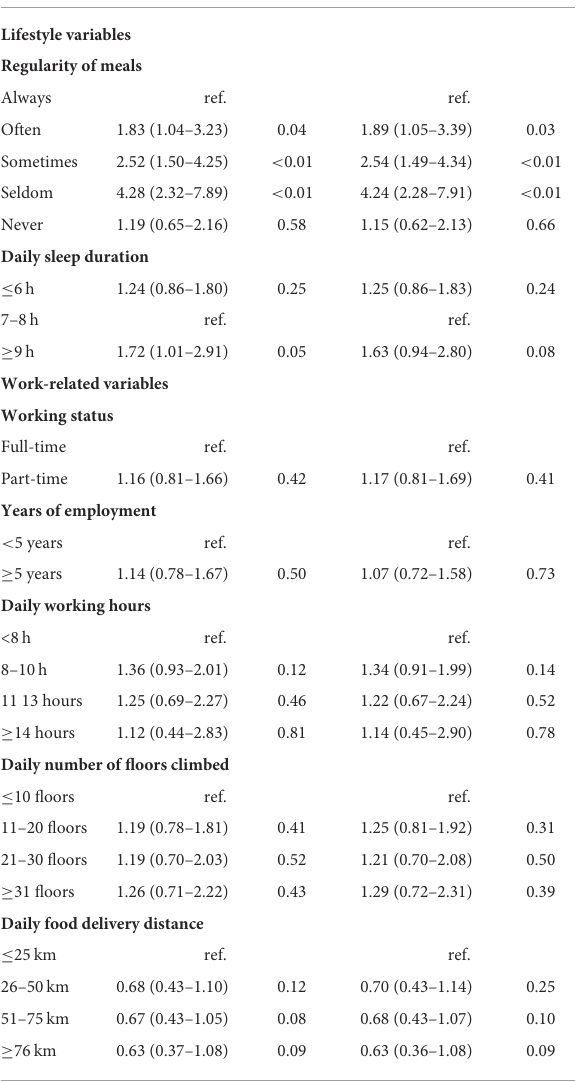
TABLE 2 Possible influencing factors of the occurrence of MSDs symptoms.